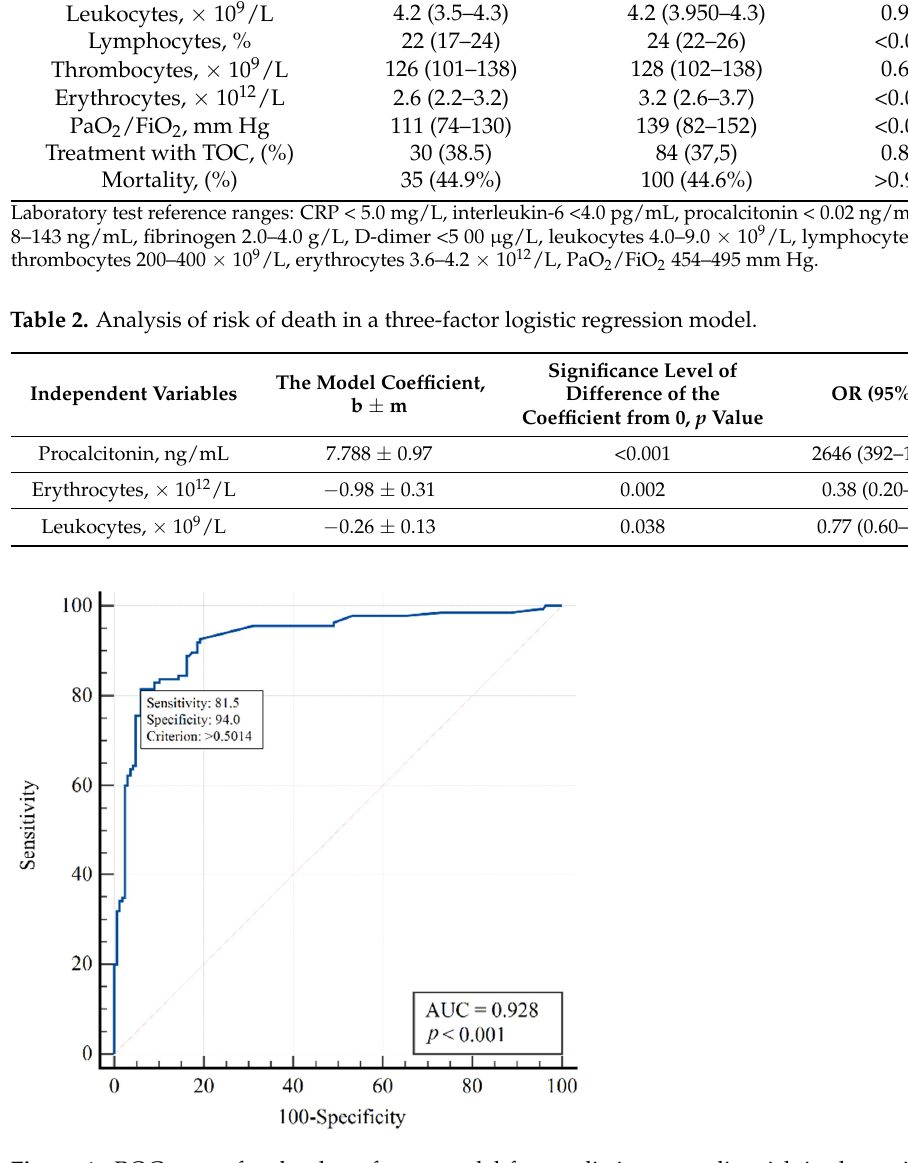
Figure 1. ROC curve for the three-factor model for predicting mortality risk in the entire study population comprising both Delta and no-Delta patients. Multivariate logistic regression model using procalcitonin, erythrocytes, and leukocytes.